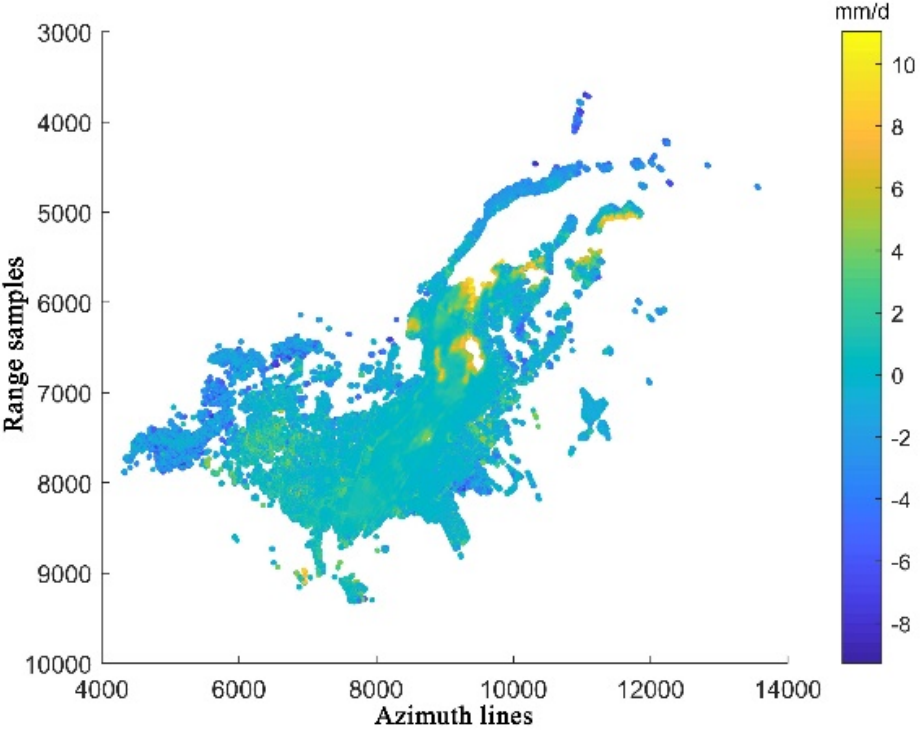
Figure 21. Final deformation rate graph. The slide body can be clearly identified from the figure and the deformation of the slide body can be analyzed.